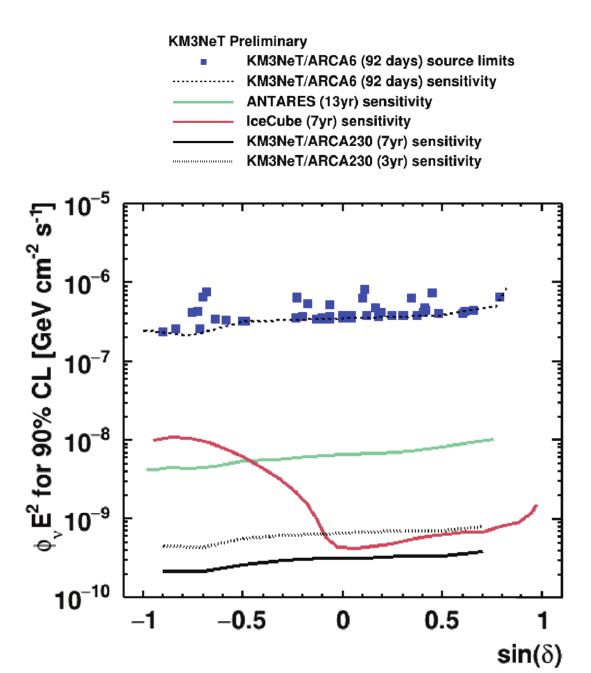
Figure 5: 90% flux limit as a function of declination re- ported for each candidate source in the catalogue. Sensi- tivity of ARCA6 (92 days, dashed blue line), ANTARES (13 yr, solid green line) and IceCube (7 yr, solid red line) are shown. The estimated sensitivity for ARCA in its final configuration is also shown, for respectively 3 and 7 years of data-taking (dashed and solid black lines).